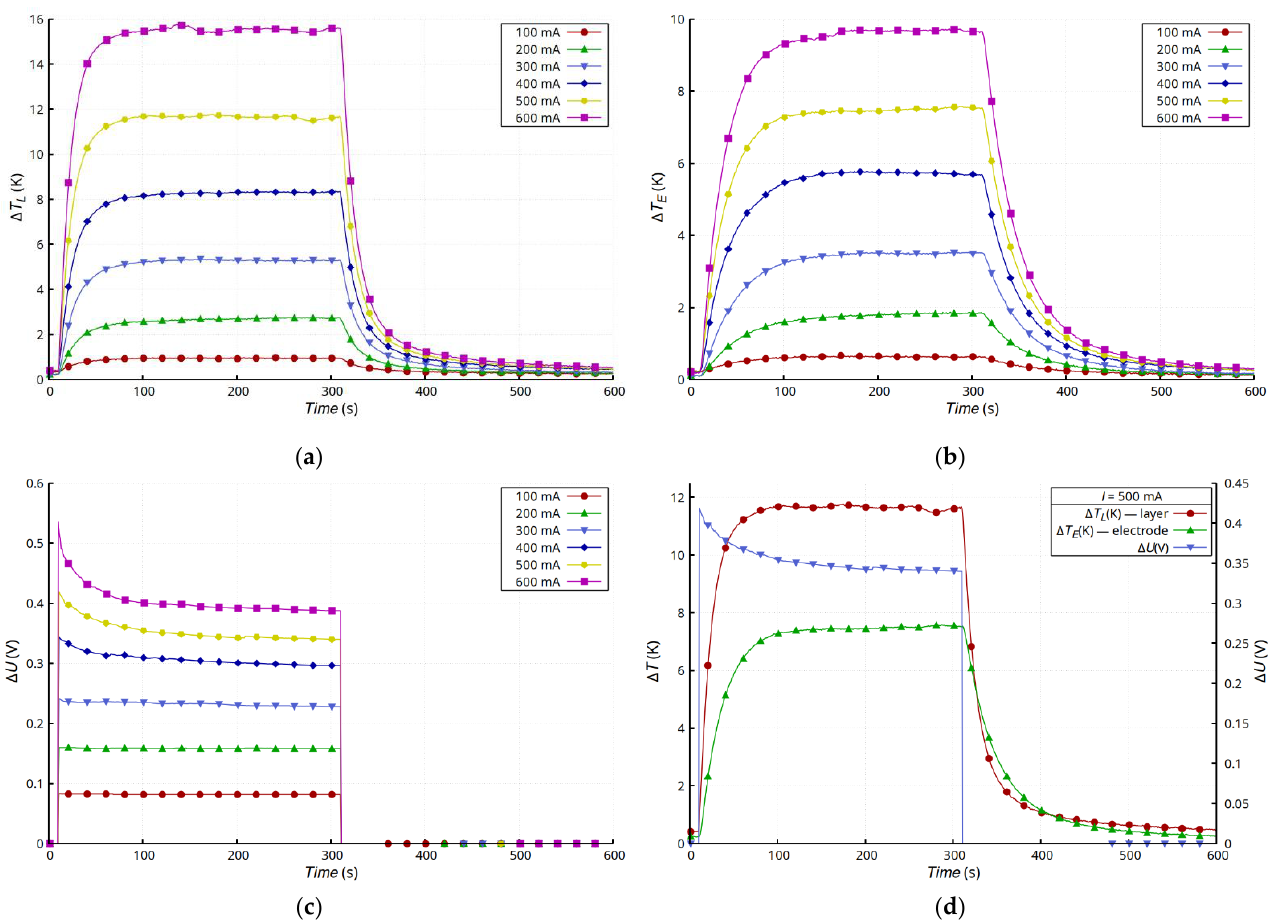
Figure 6. Results for C + T sample: time dependence of changes in temperature of Ag layer Δ T L ( a ), changes in temperature of electrode Δ T E ( b ), and drop voltage on sample Δ U ( c ), as well as comparison of results for I = 500 mA ( d ).